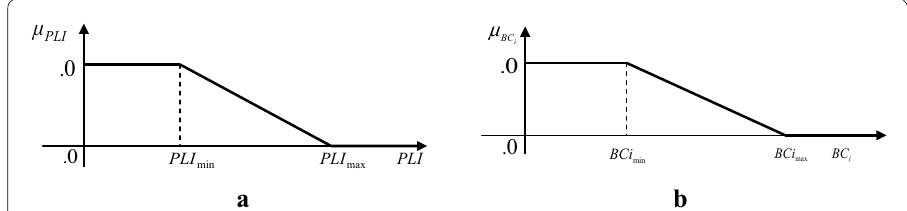
Fig. 3 a Membership function for active power loss reduction. b Membership function for branch current